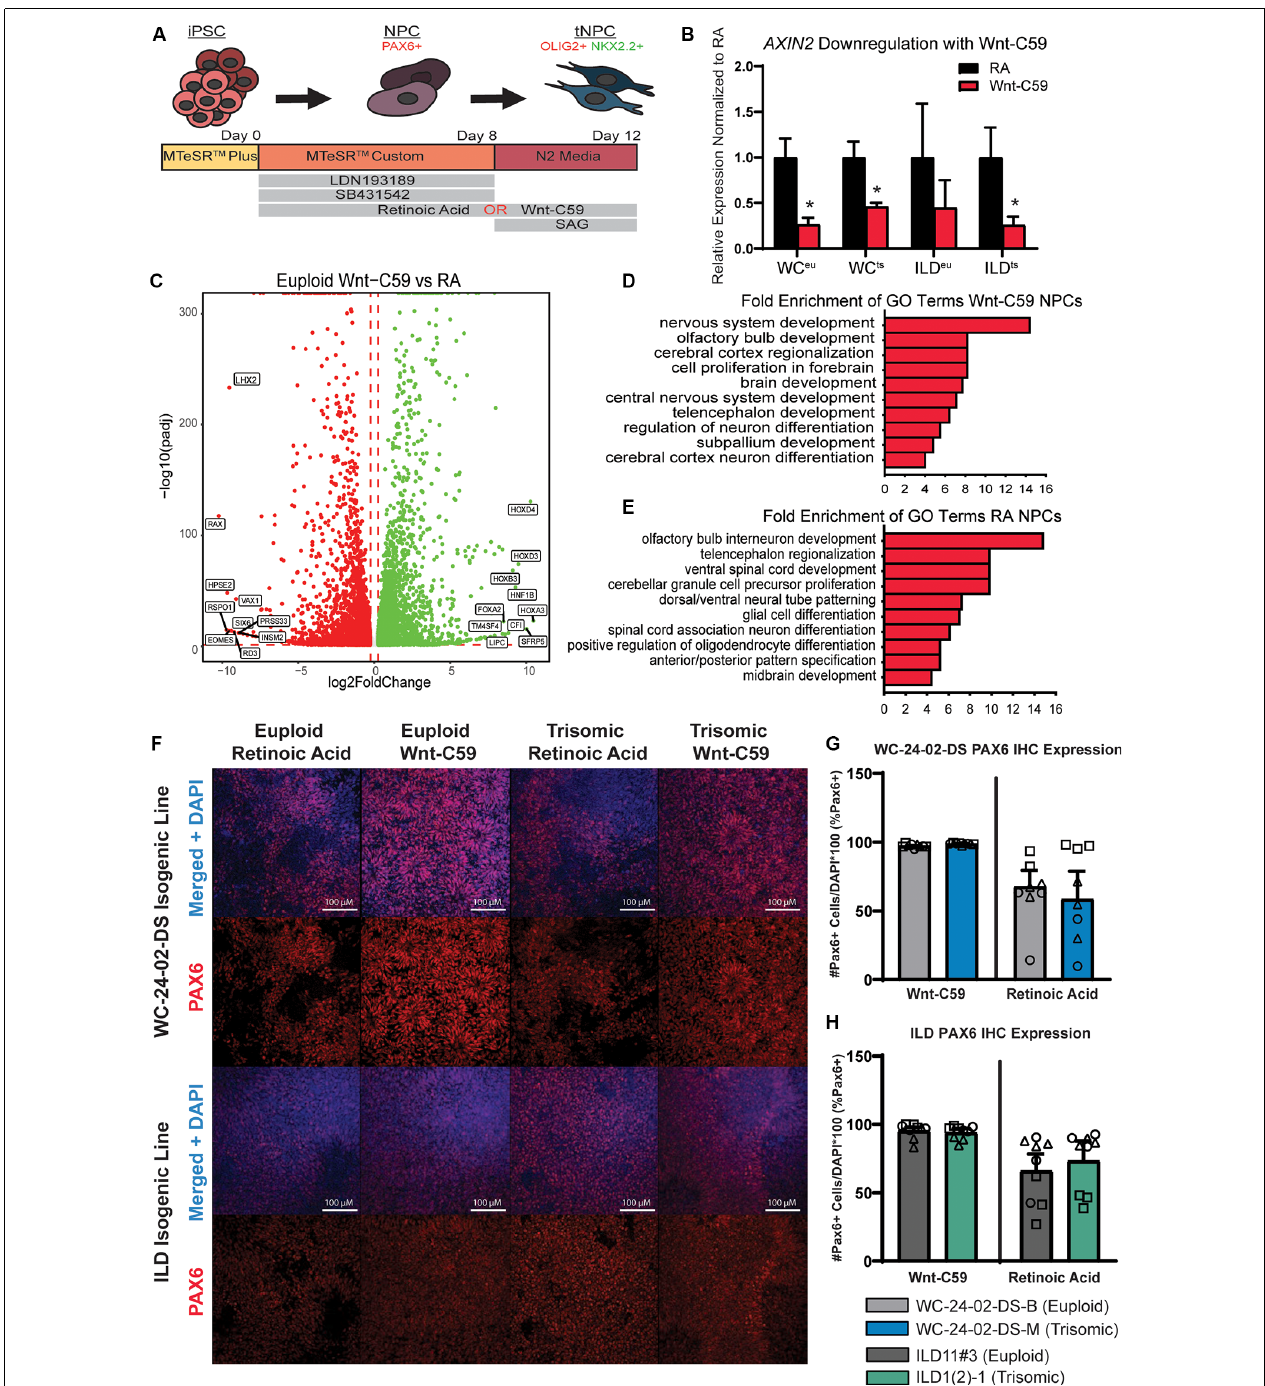
FIGURE 1 | Generation of PAX6+ NPCs with different regional characteristics. (A) Schematic of experimental design. (B) Treatment of iPSC cultures with Wnt-C59 significantly decreases expression of AXIN2 , a direct Wnt pathway target, in all cell lines used (WC eu , WC ts , ILD eu , and ILD ts ). (C) 9,197 genes are differentially expressed in euploid NPCs differentiated with either RA or Wnt-C59. (D) GO analysis identifies biological processes significantly enriched in Wnt-C59 NPCs relating to the rostral CNS. (E) GO analysis identifies biological processes relating to the caudal CNS significantly enriched in NPCs treated with RA. (F) Differentiation of the iPSCs with either RA or Wnt-C59 produce a pool of PAX6+ NPCs in both euploid and trisomic cultures. (G) In the WC-24–02-DS isogenic pair, there are no significant differences either between genotype or condition in the percentage of PAX6+ cells in culture, though the cultures treated with Wnt-C59 show less variability between differentiation experiments. (H) The same pattern of PAX6 expression is repeated in the ILD isogenic pair. n = 3, three independent differentiation experiments with values from each individual well (three per differentiation) overlaid. Data are shown as mean ± SEM. * p -value < 0.05 with specific values in text.